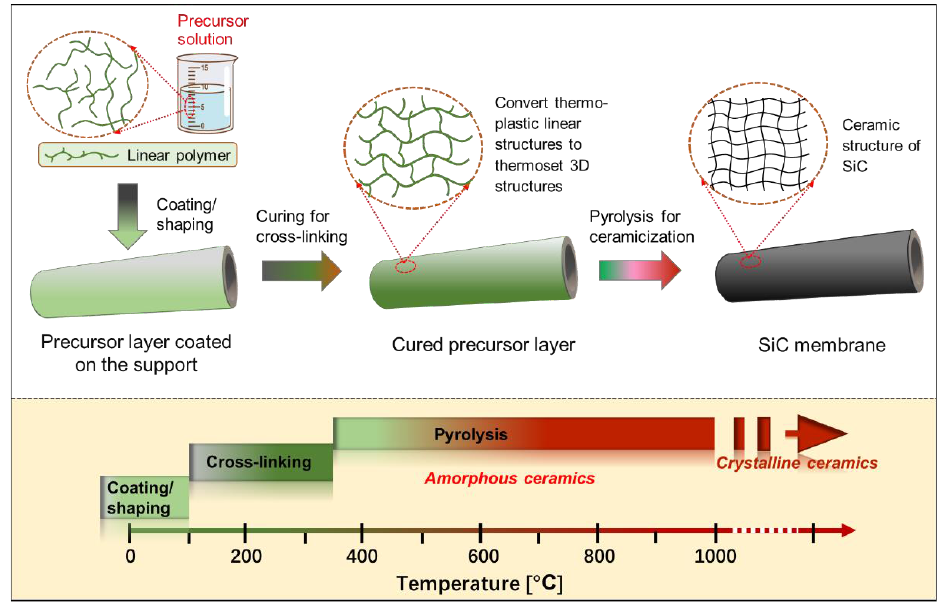
Figure 6. Schematic of pyrolysis for the preceramic precursor route to manufacture SiC membranes. These steps are also temperature dependent and are shown at the bottom.